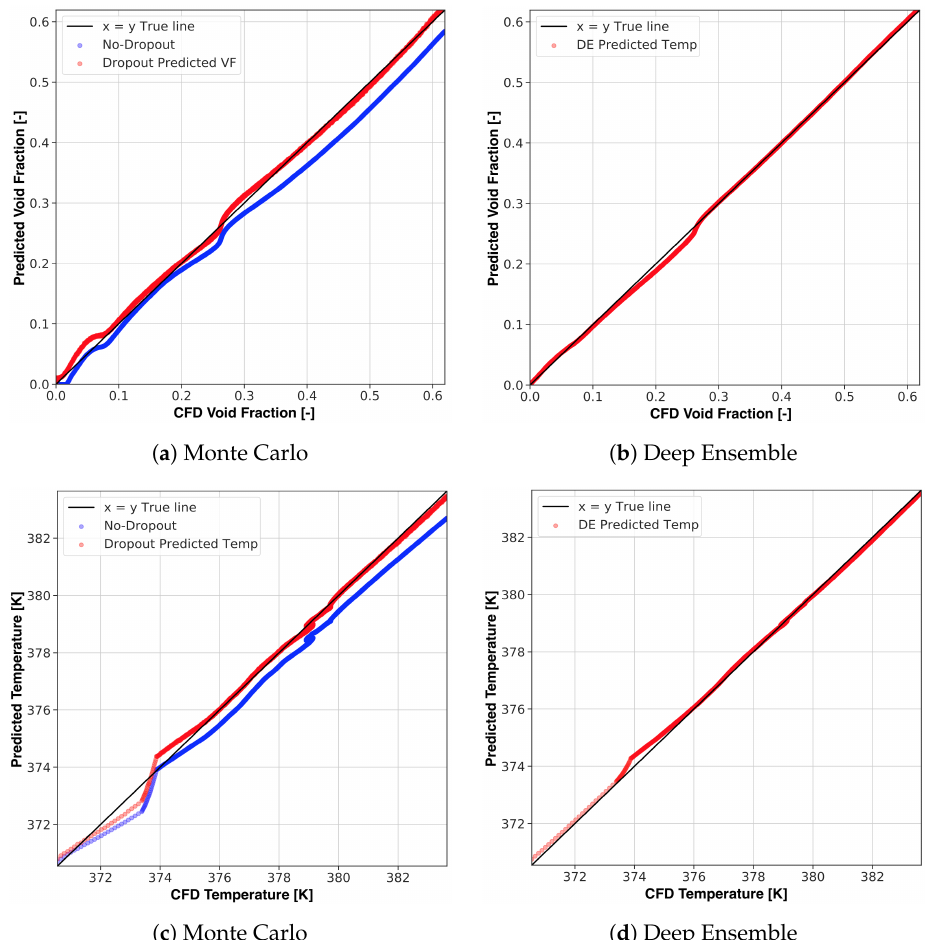
Figure 9. Regression chart for interpolation dataset using Monte Carlo and Deep Ensemble for void fraction and wall temperature at q (cid:48)(cid:48) = 40,000 Wm − 2 and u = 0.2 ms − 1